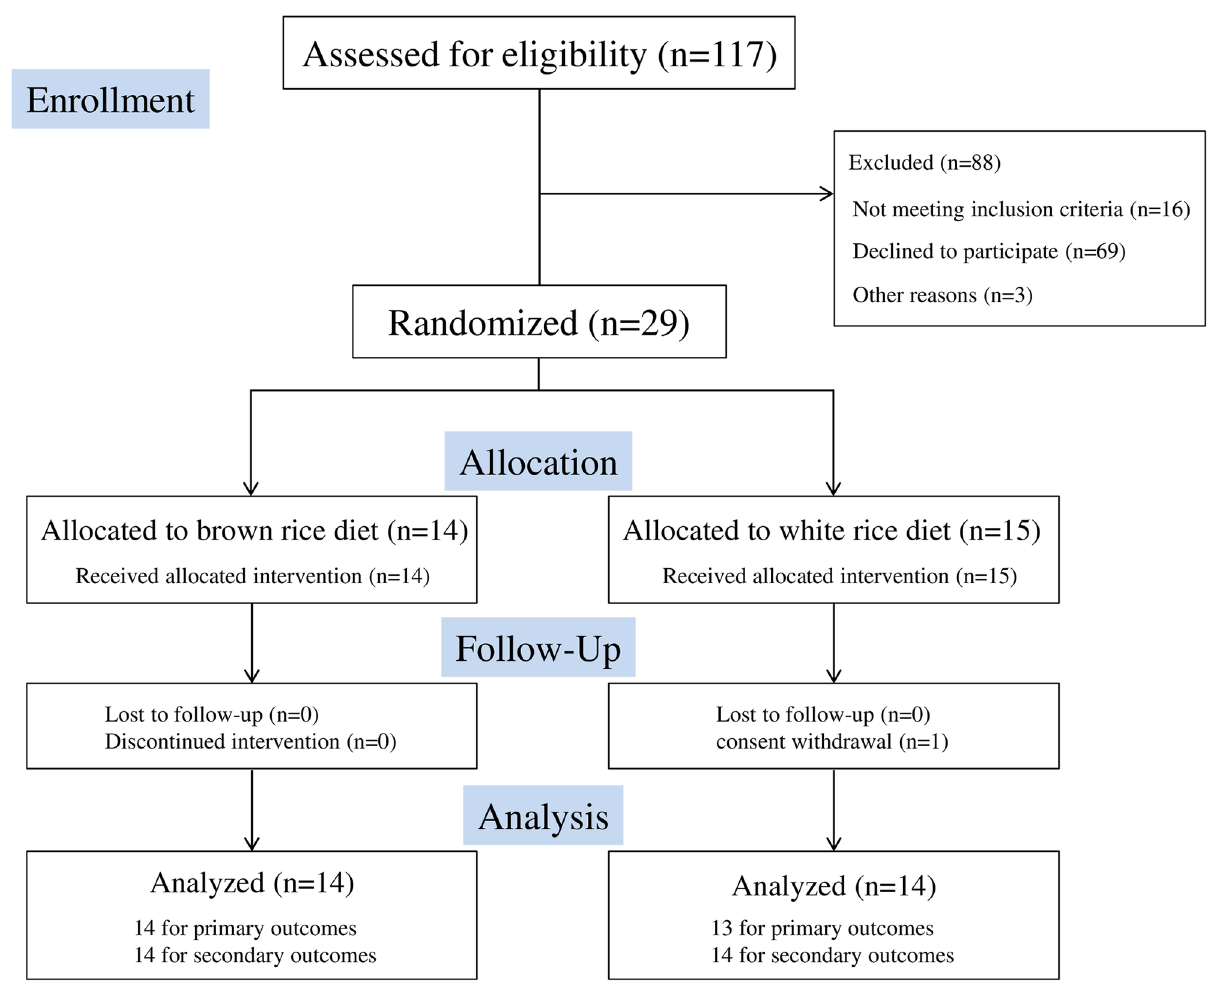
Fig 1. Flow chart showing the recruitment of